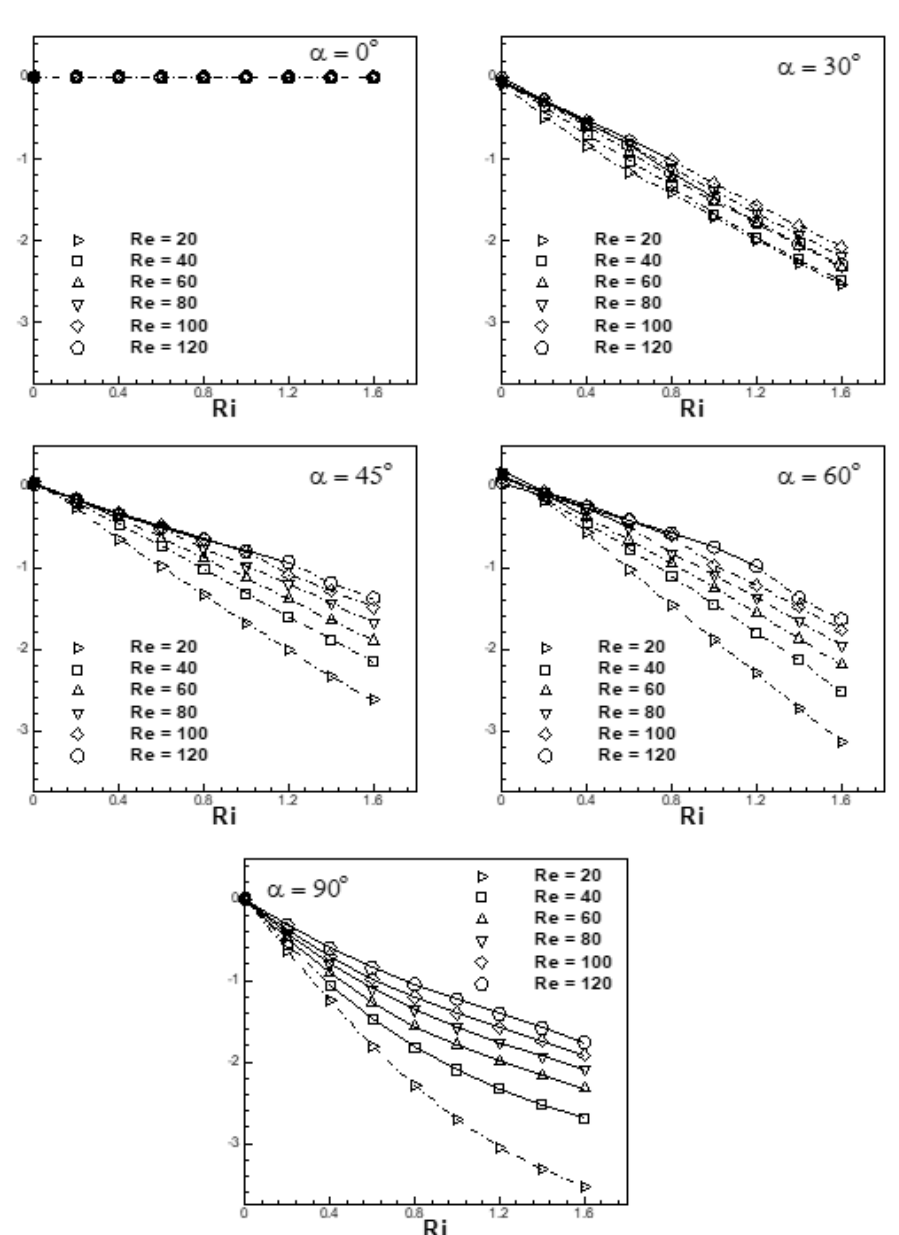
N u / ( N u ) Figure 31. Variation of time mean Nusselt number ( R i 0 . 0 = ) as a function of Richardson Figure 23. Time mean lift coefficient vs. Richardson number for the conditions (20 ≤ Re ≤ 120, 0 ° ≤ α 0 ◦ ≤ α ≤ 90 ◦ and 0 ≤ Ri ≤ 1.6) (— — — — steady flow, number for 20 ≤ Re ≤ 120, 0 ° ≤ α ≤ 90° and 0 ≤ Ri ≤ 1.6 (— — — — steady flow, unsteady ≤ 90 ° and 0 ≤ Ri ≤ 1.6) ( — — — — steady flow, unsteady flow).